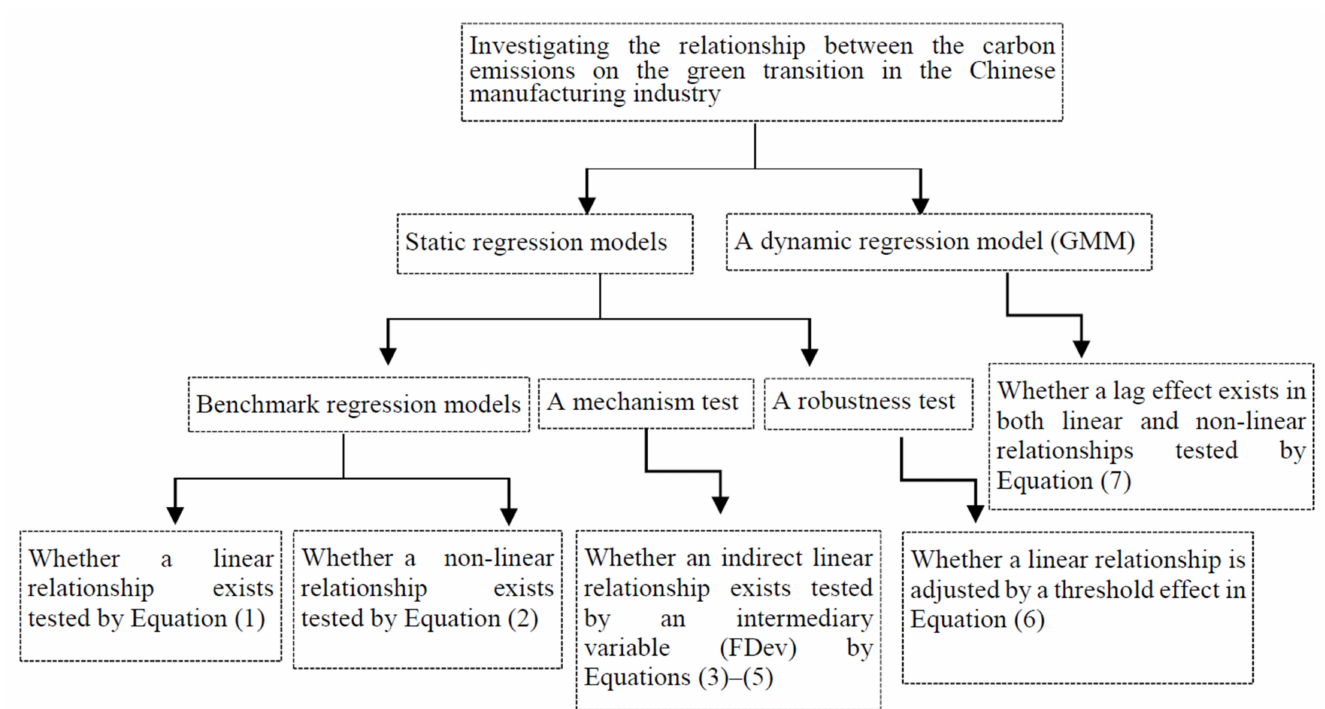
Figure 3. Methodology mind-map.